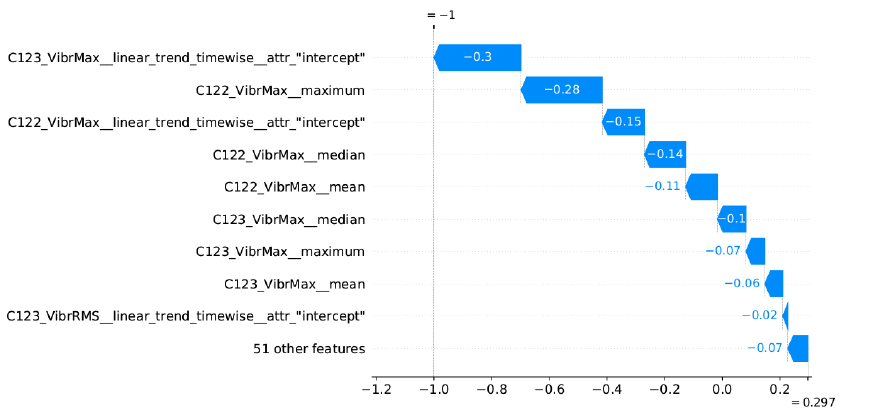
Figure 14. Selected excerpt from the plot of the most significant features indicated by the explanatory model in Figure 13.